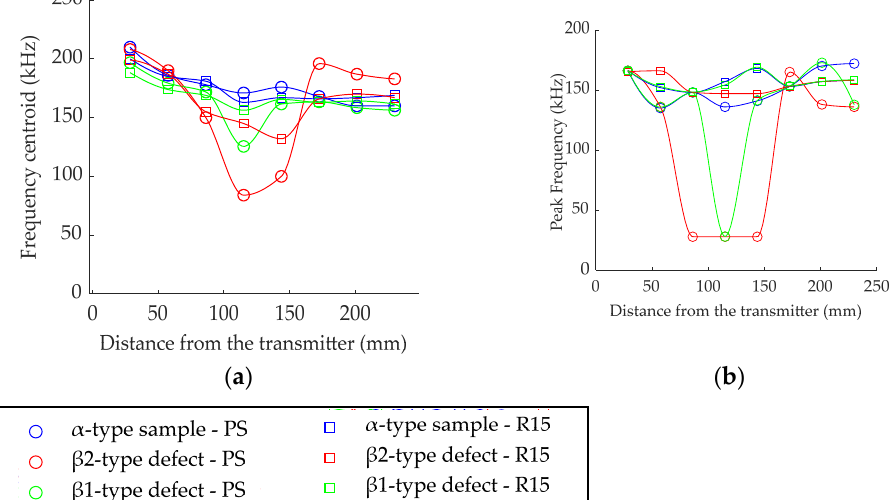
Figure 8. Variation of ( a ) frequency centroid and ( b ) peak frequency versus the distance between the emitter and the perfect sensor (PS, o) or R15 sensor (□) for the various assemblies.